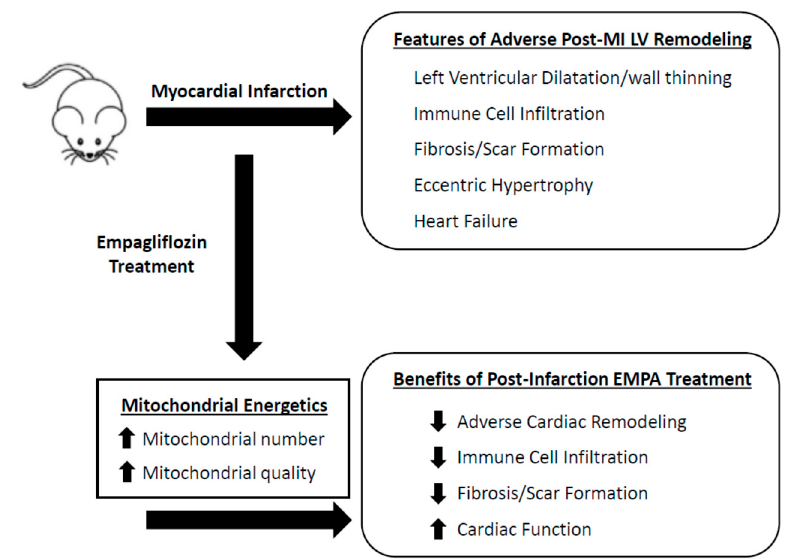
Figure 6. Empagliflozin attenuates infarct-induced adverse cardiac remodeling. Post-MI administration of empagliflozin leads to improved mitochondrial energetics by increasing mitochondrial biogenesis and enhancing the quality of the mitochondrial population in cardiac cells. This is associated with decreasing immune cell infiltration to the border zone, decreasing fibrosis and scar formation and ultimately attenuating adverse remodeling of the heart and delaying the onset of heart failure.